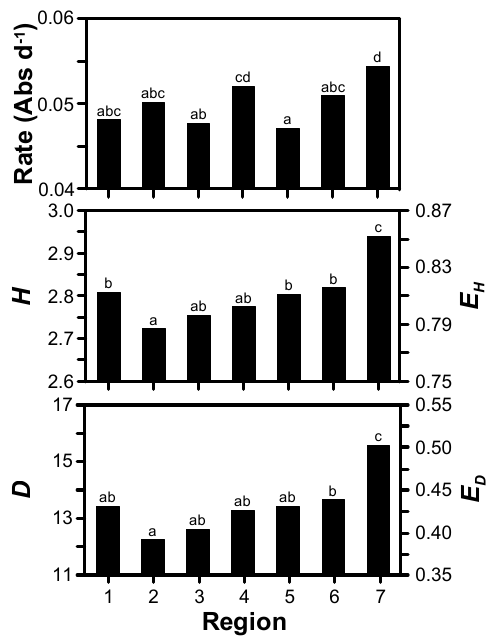
Figure 2. Microbial substrate utilization rate (absorbance day -1 ), Shannon’s diversity ( H ) and evenness ( E H ), and Simpson’s diversity ( D ) and evenness ( E D ), averaged across yield areas, measured in the seven regions of the “Grow for the Green” yield contest across Arkansas in 2014 and 2015. Bars with different letters are significantly different (i.e., p ≤ 0.05).